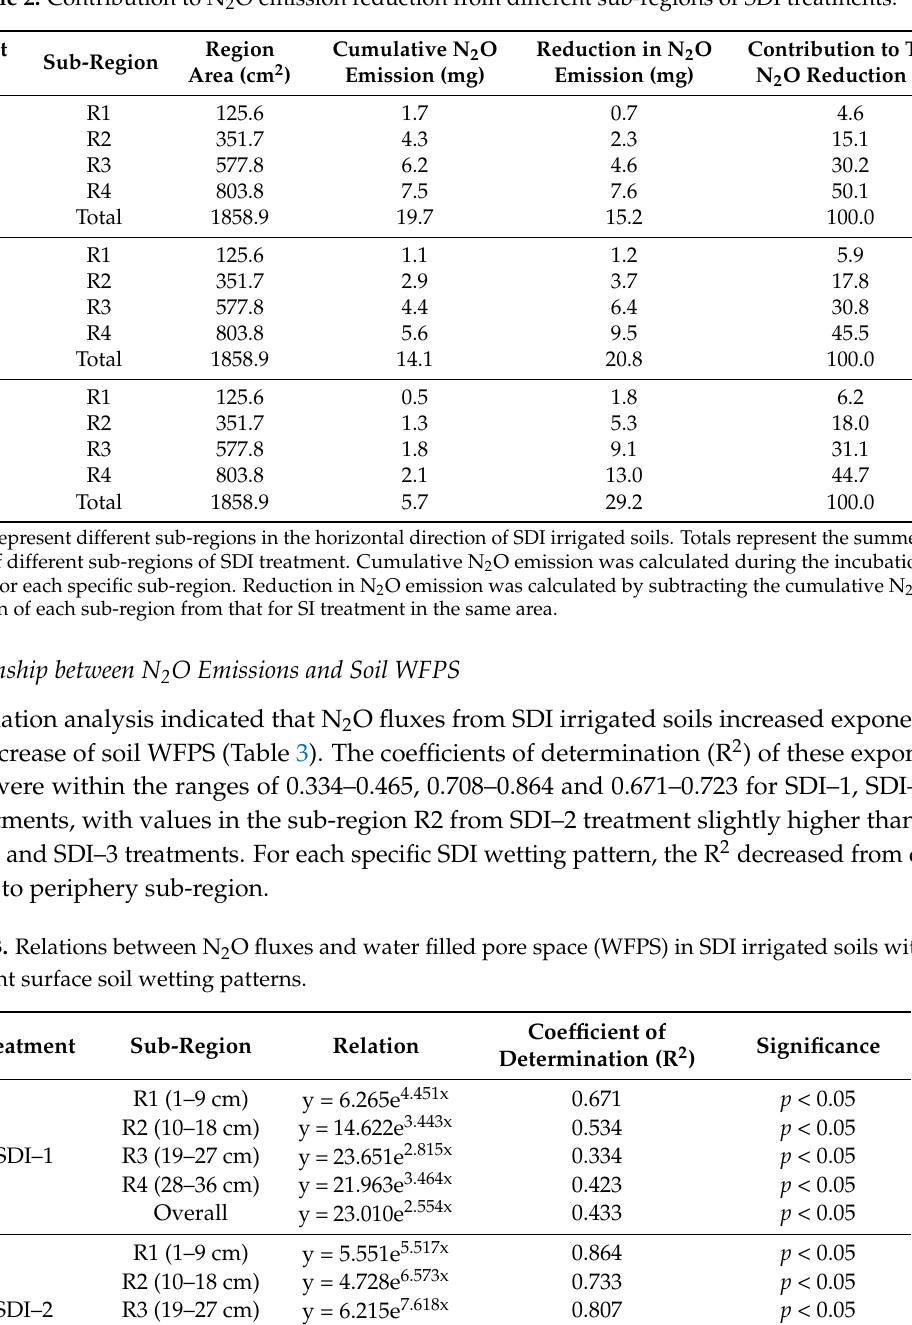
Table 2. Contribution to N 2 O emission reduction from different sub-regions of SDI treatments.